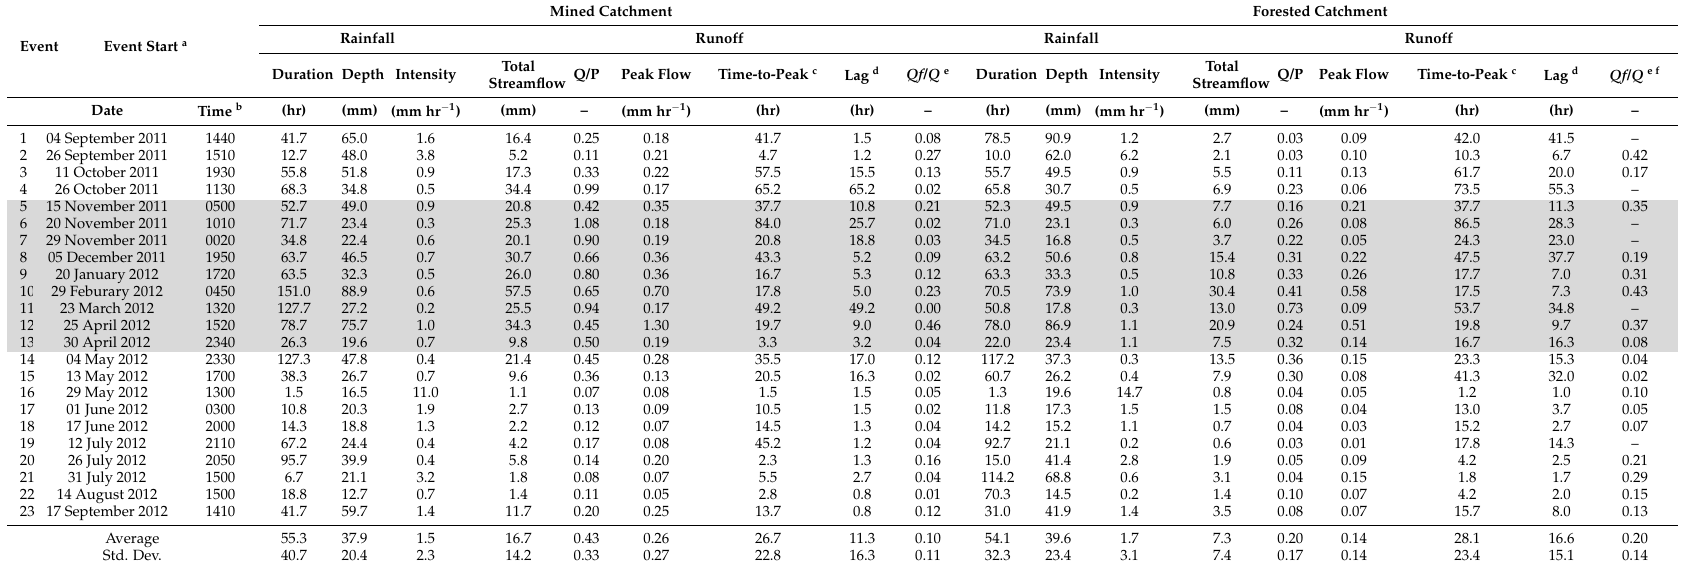
Table 2. Rainfall and runoff storm characteristics and hydrologic response times for 23 events measured in the mined and forested catchment over the 13-month study period. Dormant season events are